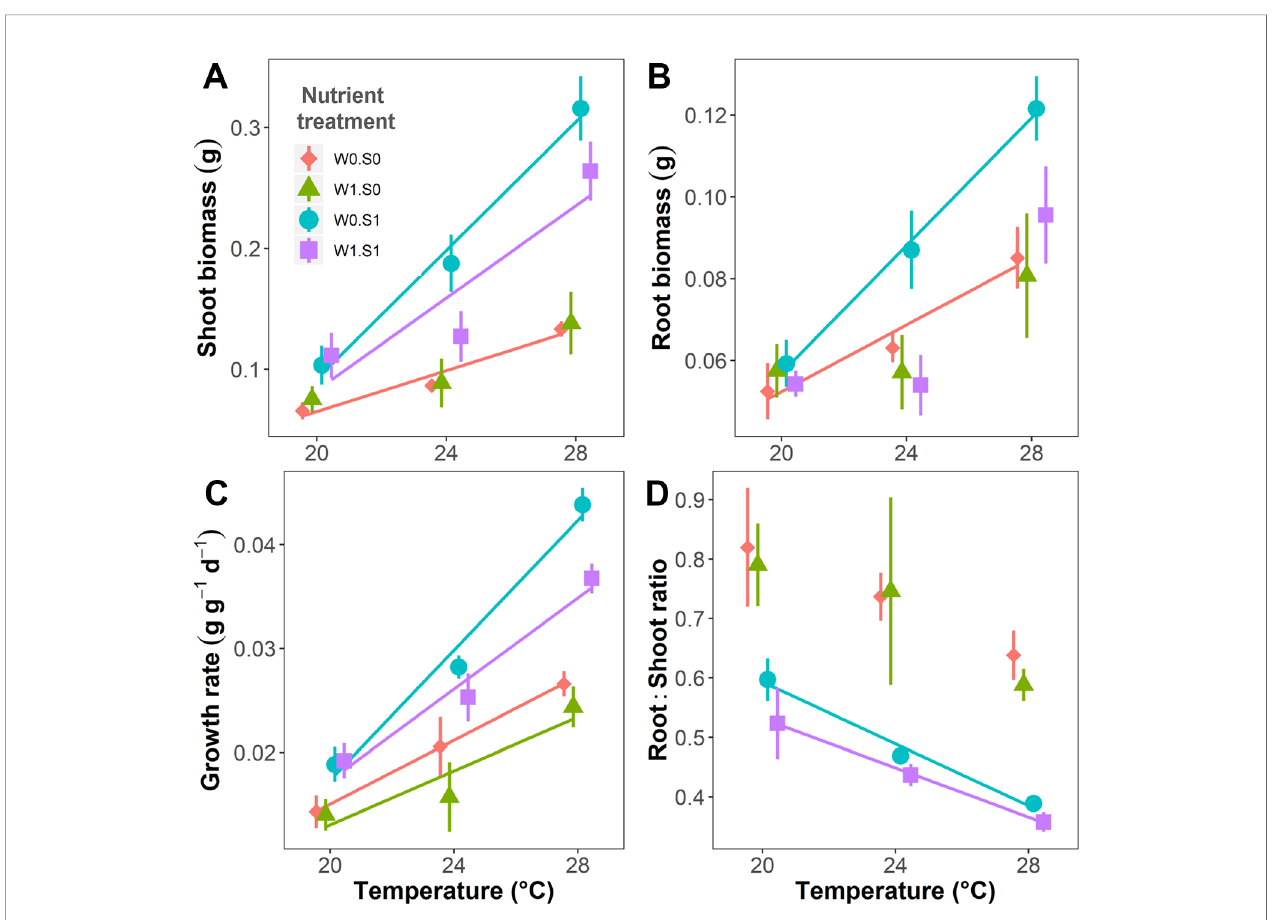
FIGURE 2 | Temperature effects on plant growth parameters indicated per nutrient treatment. (A) Plant shoot biomass, (B) root biomass, (C) relative growth rate, and (D) root:shoot ratio. S1 indicates nutrient-rich sediment, S0 indicates nutrient-poor sediment, W1 indicates with external nutrient loading to the water, and W0 indicates without external nutrient loading. A solid line indicates p < 0.05, and no line is drawn when p > 0.05. Vertical bars are standard errors (n =